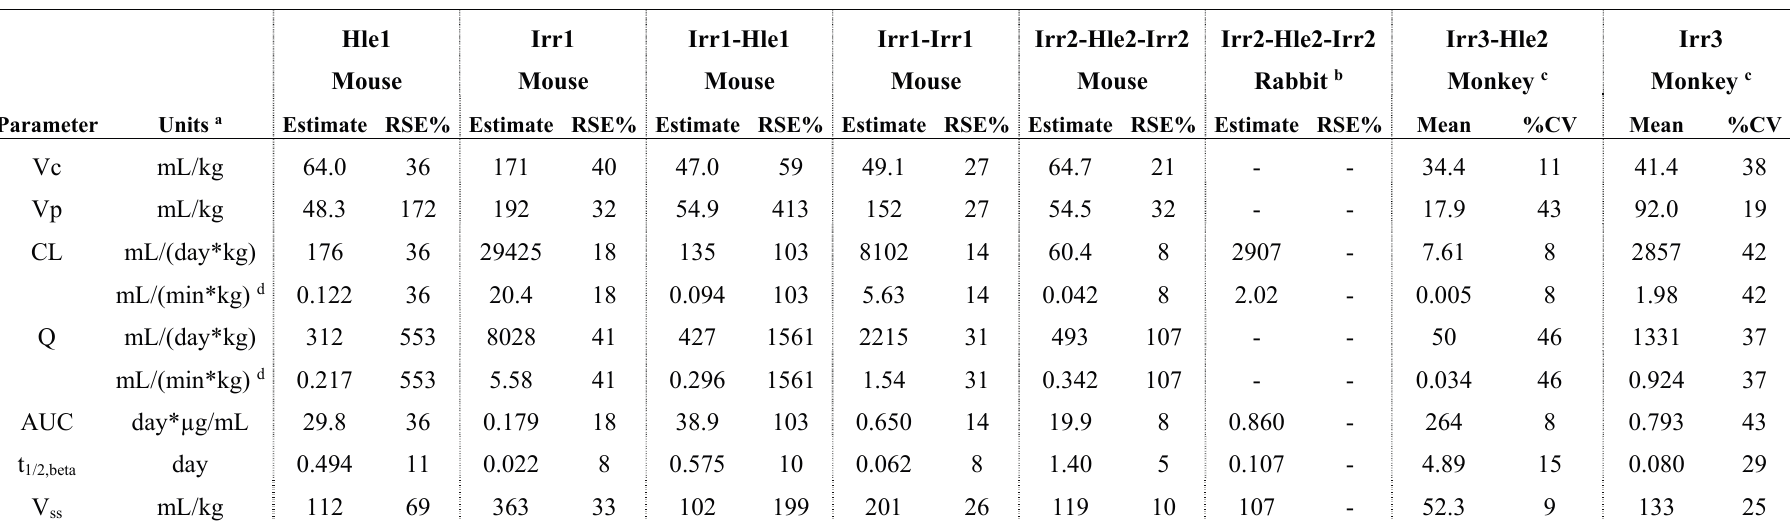
Table 2. Main serum PK parameters of tested Nanobodies in mice, rabbits or cynomolgus monkeys after single i.v. administration. Hle1 Irr1 Mouse Mouse Monkey c